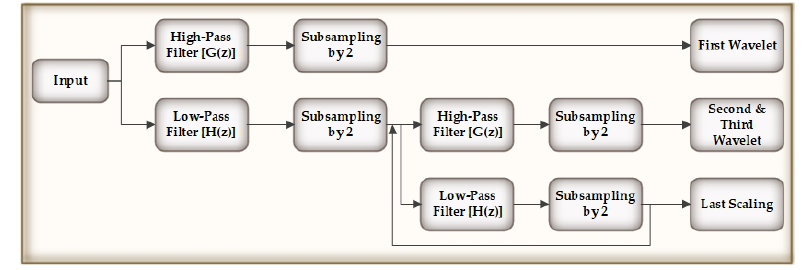
Figure 2. Discrete Wavelet Transform